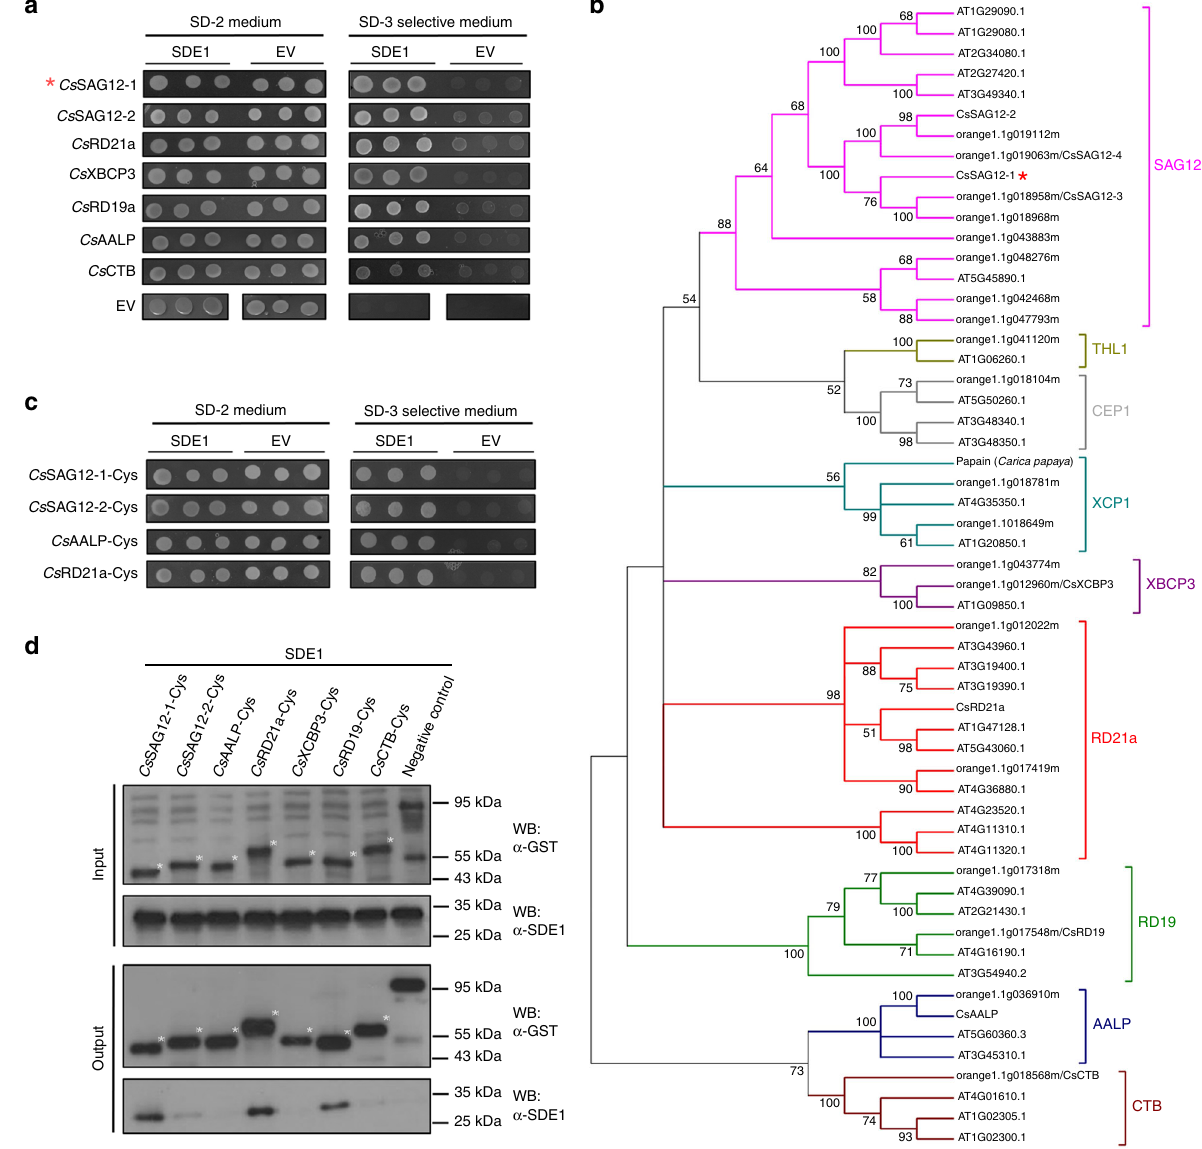
Fig. 1 SDE1 interacts with citrus papain-like cysteine proteases. a Yeast-two-hybrid (Y2H) assays using the C Las effector SDE1 as the bait and full-length citrus papain-like cysteine proteases ( Cs PLCPs), representing different subfamilies as the prey. SDE1 was cloned into the vector pGBKT7 and individual Cs PLCPs were cloned into the vector pGADT7. Growth of yeast cells on SD-3 selective media represents protein – protein interaction, growth of the same cells on SD-2 media con fi rms yeast transformation. Yeast transformed with the empty vectors served as negative controls. The initial PLCP found from Y2H screening ( Cs SAG12-1, XM_006495158) is indicated with an asterisk (*). The gene IDs of the other interacting PLCPs are Cs SAG12-2 (XM_006470229), Cs XCBP3 (orange1.1g012960), Cs RD21a (XM_006473212), Cs RD19 (orange1.1g017548), Cs AALP (XM_006474664), and Cs CTB (orange1.1g018568). b Phylogeny and subfamily classi fi cation of canonical PLCPs in the C . sinensis (sweet orange) genome. The phylogenetic tree was made with MEGA6.06 (100 bootstrap replicates, Maximum-Likelihood method, Jones – Taylor – Thornton model), using the Arabidopsis thaliana PLCP subfamily classi fi cation 22 . The asterisk (*) indicates the initially found Cs SAG12-1. c Y2H assay examining the interaction of SDE1 with the cysteine protease domain of Cs PLCPs. d In vitro pull-down assay using the GST-tagged cysteine protease domain of Cs PLCPs to immunoprecipitate SDE1 protein. Input and immunoprecipitated proteins (output) were visualized by western blotting using anti-GST and anti-SDE1 antibodies. Asterisks (*) indicate the protein bands that correspond to individual Cs PLCPs. GST-tagged Arabidopsis double-stranded DNA-binding protein 4 ( At DRB4) was used as a negative